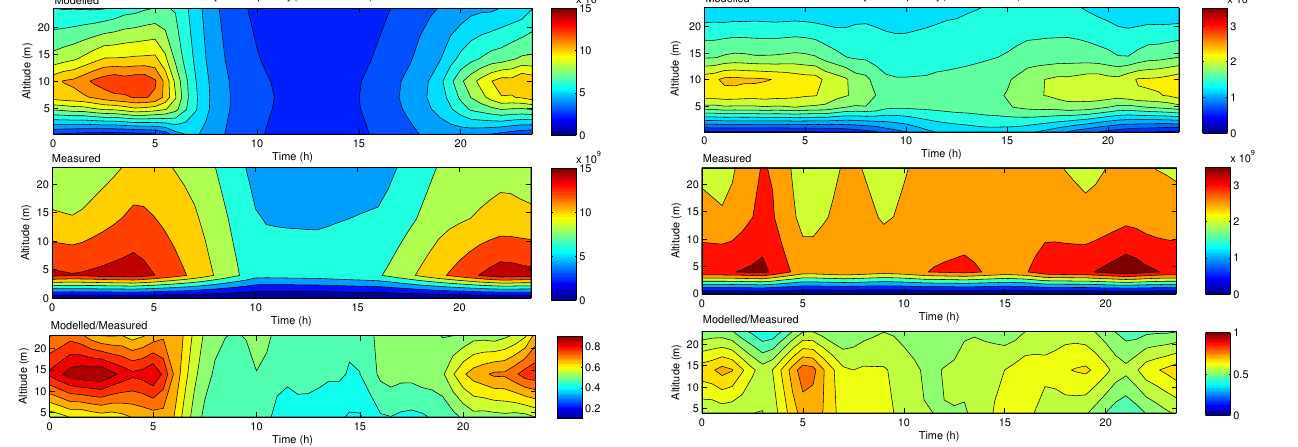
Figure 12. Modelled (MEGAN 2.04) and measured (at the SMEAR II station) monoterpene concentration vertical profiles for summer 2007.